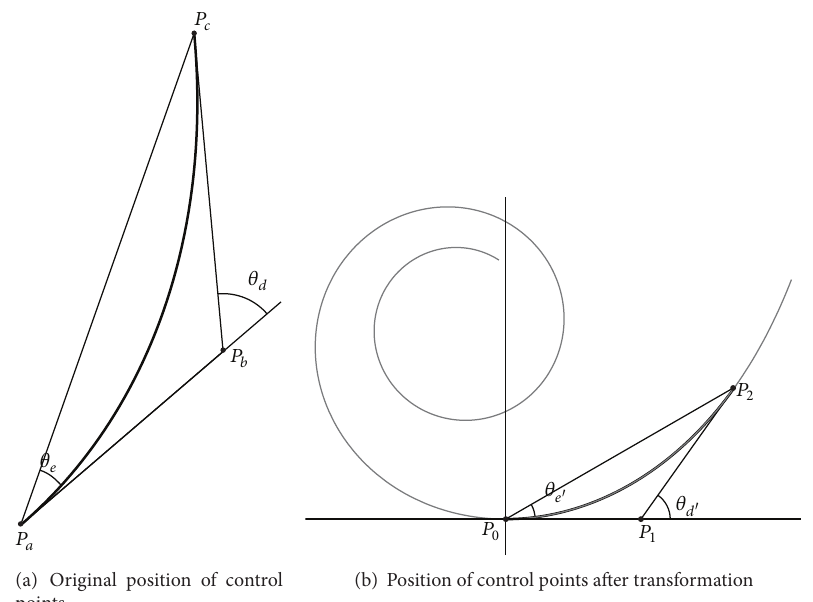
Figure 3: The configuration of triangle consists of three control points for case 𝛼 ≤ 1 . The curve inside the triangle represents the generated LAC segment.